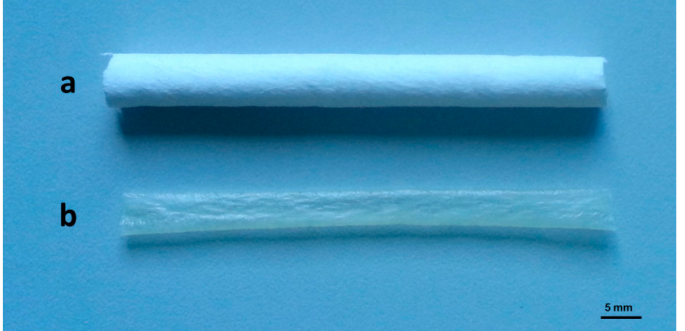
Figure 6. A polyurethane (PU) tube ( a ; l = 60 mm, d = 6 mm) and a collagen tube ( b ; l = 60 mm, d = 3